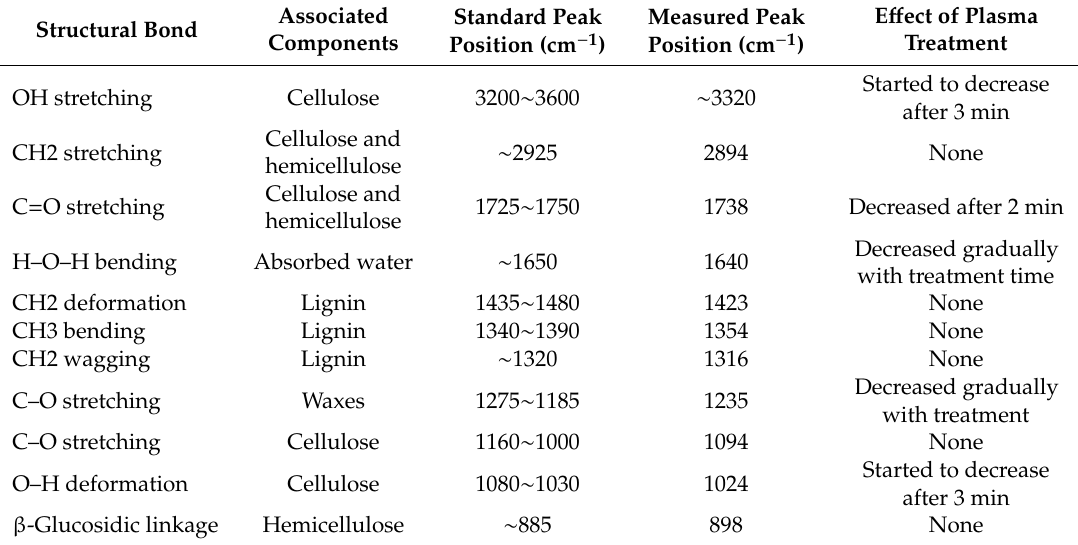
Table 1. Standard [43–46] and observed ATR-FTIR absorption peak position for ramie